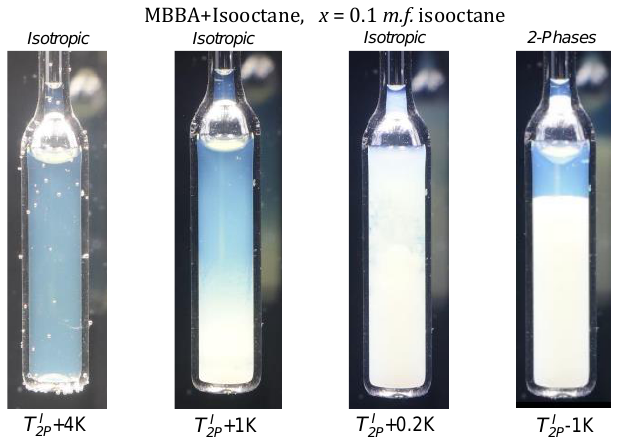
Figure 7. Photos show the pretransitional opalescence in MBBA — Isooctane mixture, 𝑥 = 0.1 𝑚.𝑓. isooctane: in the isotropic ( I ) liquid phase and the two-phase ( TP2 ) domains for 𝑇 2𝑃𝐼 − 1𝐾 .